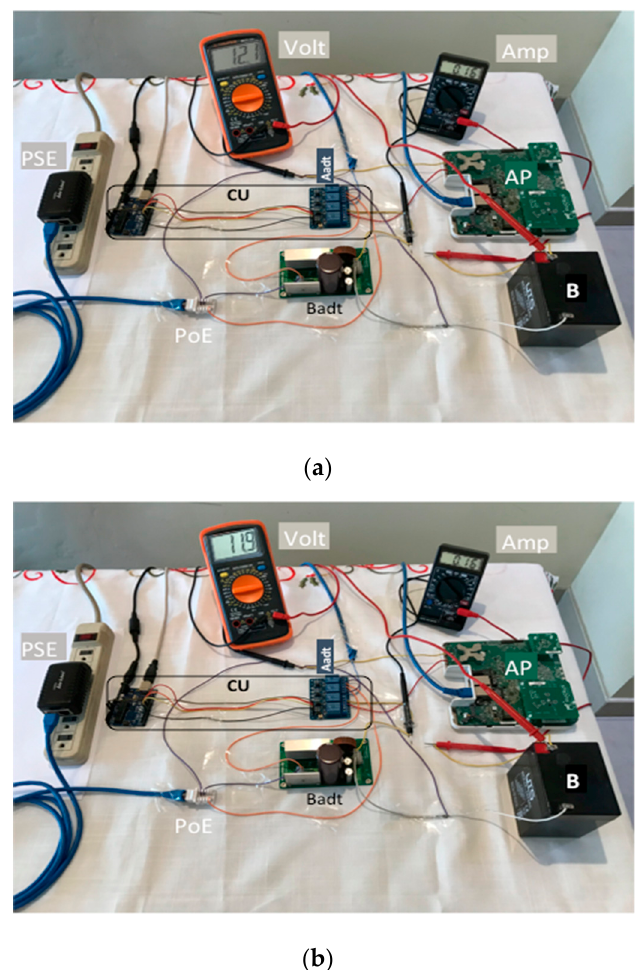
Figure 10. Discharging current ( I d ) and voltage ( V d ) of the battery with our mechanism: ( a ) OBTx-1 and ( b ) OBTx-2.